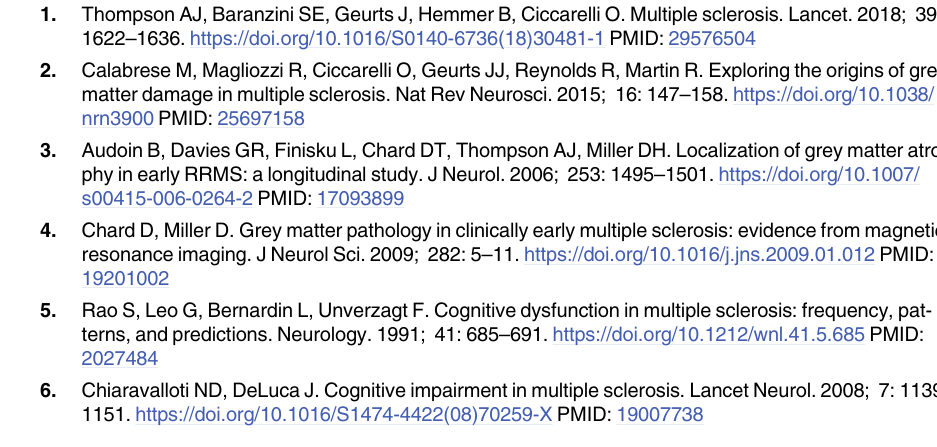
parahippocampus and the (b) right putamen in people with Multiple Sclerosis and in the area of the (c) left insula in healthy subjects. Cyan lines indicate the mean of GMV evolu- tion. (TIF) S2 Fig. Pearson’s correlation of mean grey matter volume change (y-axis) in the area of the right hippocampus/parahippocampus and change of vocabulary knowledge following sec- ond language learning in people with Multiple Sclerosis (p = 0.031; ρ = 0.74).